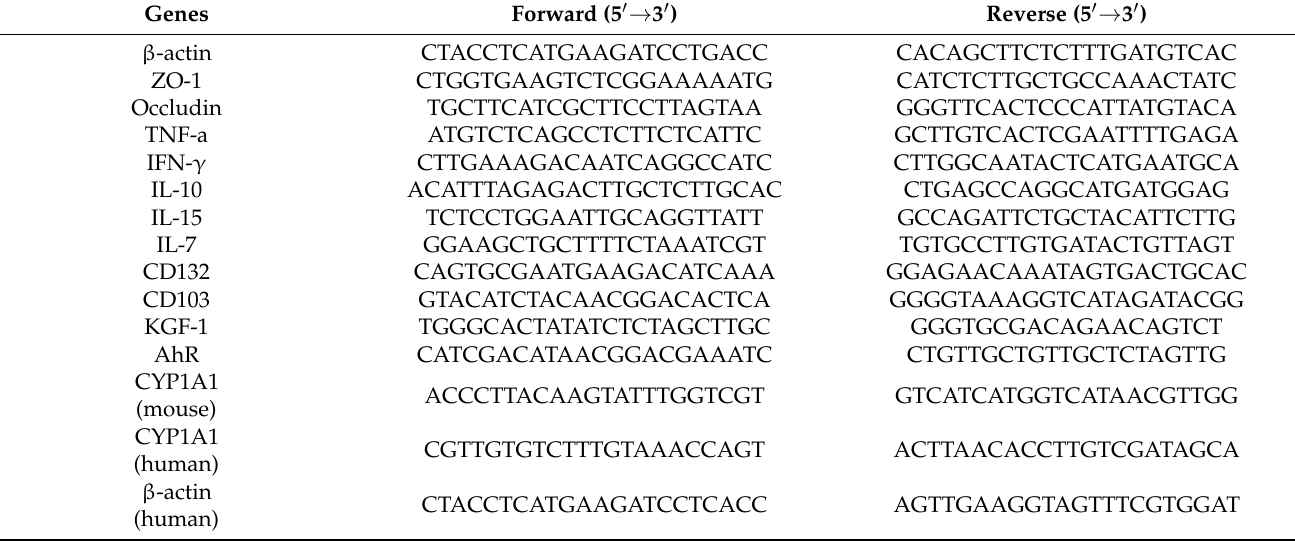
Table 1. Primers Used for Quantitative Real-Time Polymerase Chain Reaction.